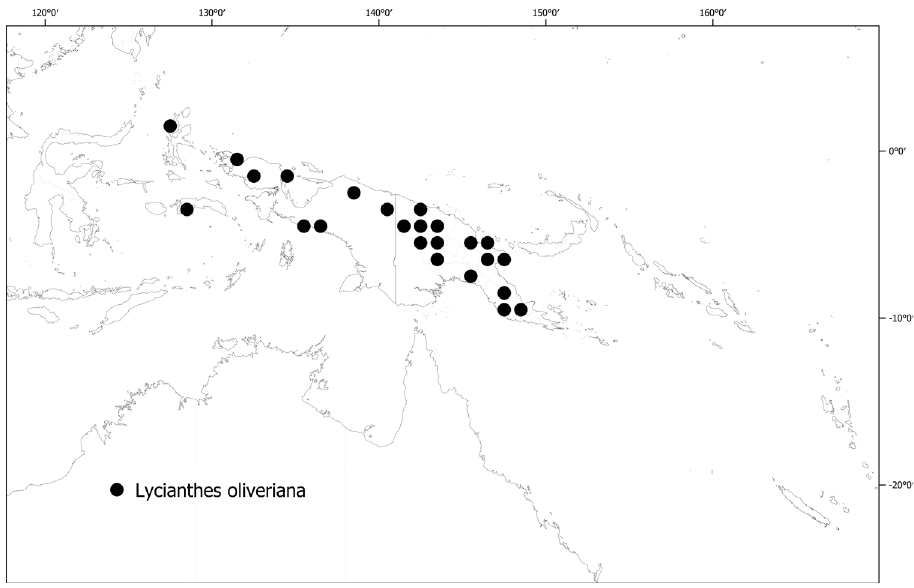
Figure 39. Distribution of Lycianthes oliveriana